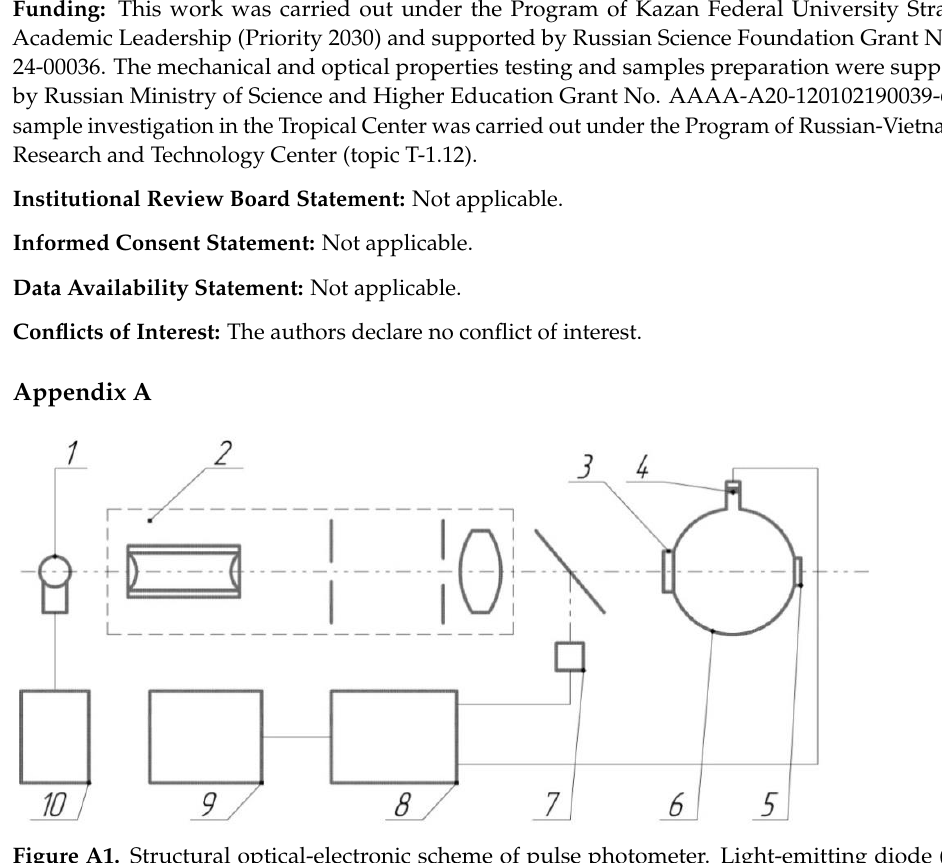
Figure A1. Structural optical-electronic scheme of pulse photometer. Light-emitting diode (LED, BL-L101URC)-1 with a wavelength of 660 nm and a spectral line width of 50 nm was used as the probing light source. The pulsed current source-10 was used to power the LED-1. The pulsed power supply mode of the LED made it possible to eliminate the effect of background illumination.